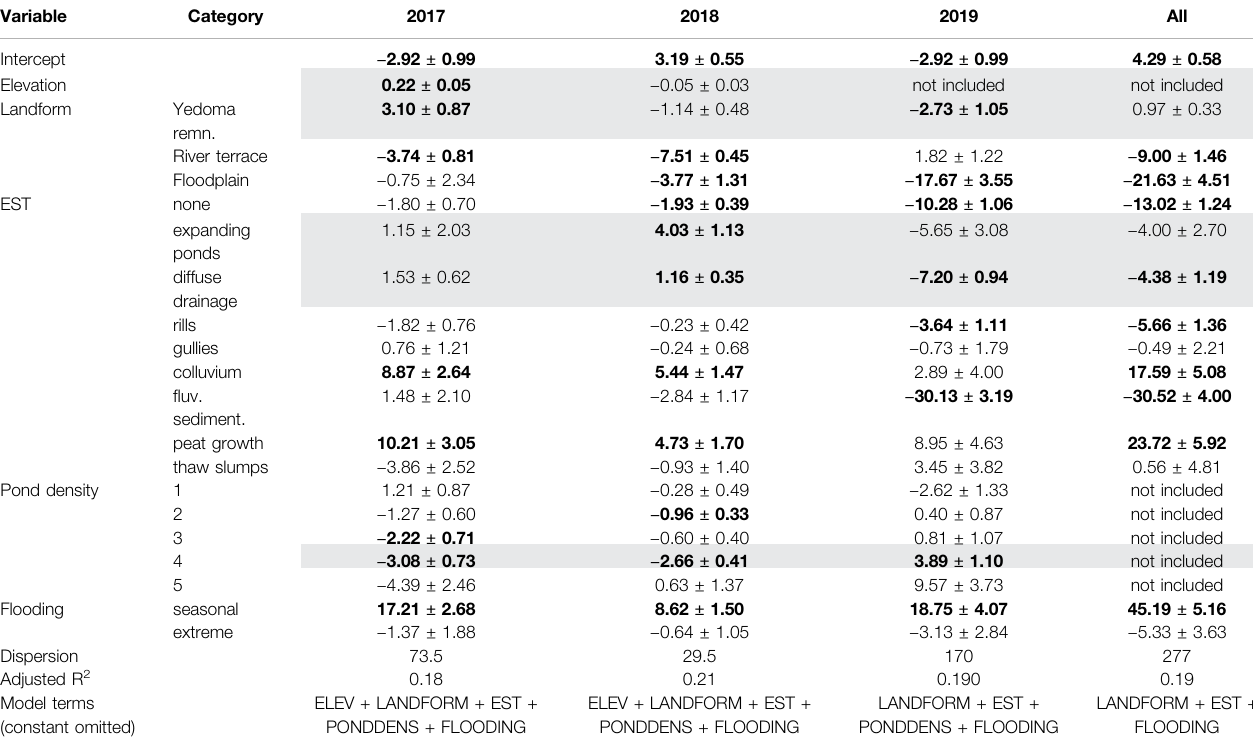
TABLE 4 | General linear regression models of surface displacements with predictors elevation (ELEV), and categorical variables Landform group, EST (erosion/ sedimentation/ground ice thaw), Pond density (PONDDENS) and Flooding.